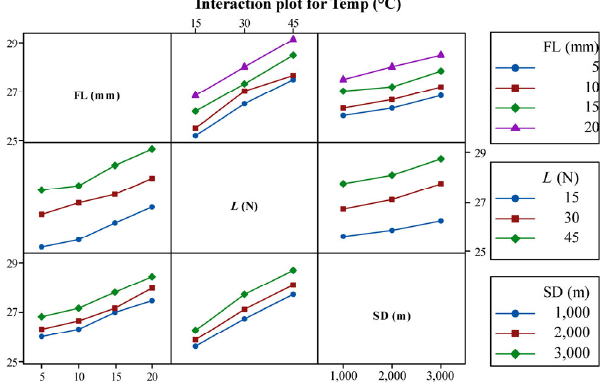
Fig. 6 Interaction plot for interfacial